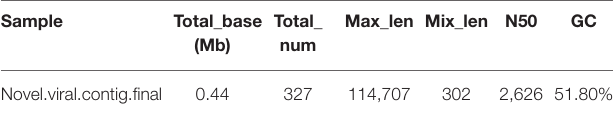
TABLE 6 | De novo virus identification result statistics.